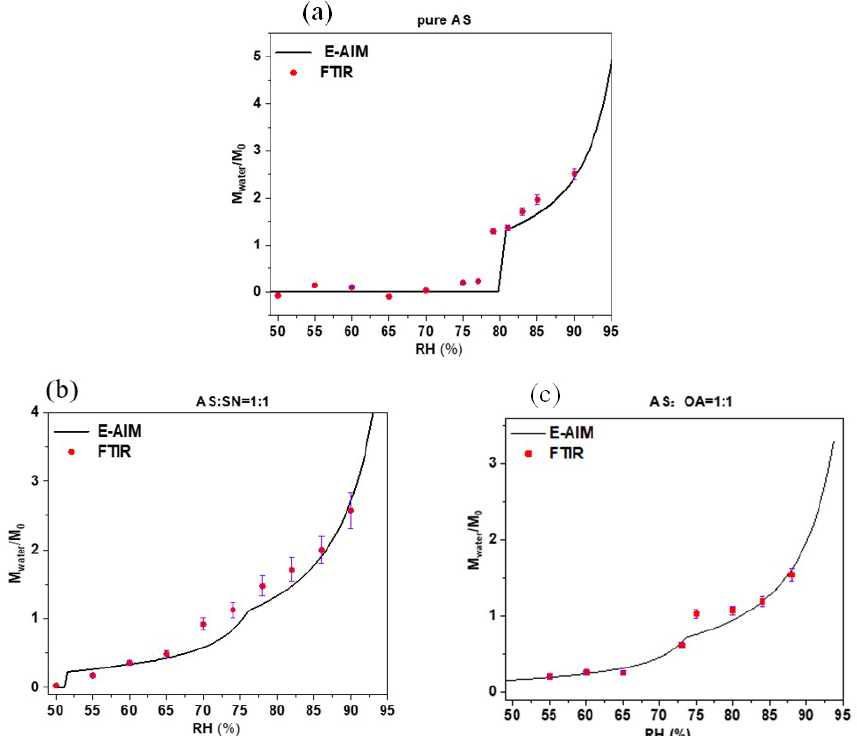
Figure 5. Comparison between the measured and predicted M water /M 0 for pure AS (a) , AS / OA (b) , and AS / SN nanoparticles (c) with a dry diameter of 100nm during the hygroscopic growth process as a function of the RH. The black curves represent the E-AIM predictions and the red square represent the measured results from the FTIR spectra. The error bar is defined as the 1 σ standard deviation of repeated